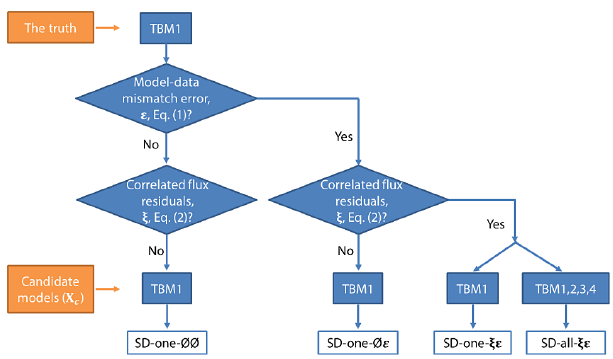
Figure 3. Illustration of Synthetic Data (SD) case studies as de- scribed in Sect.